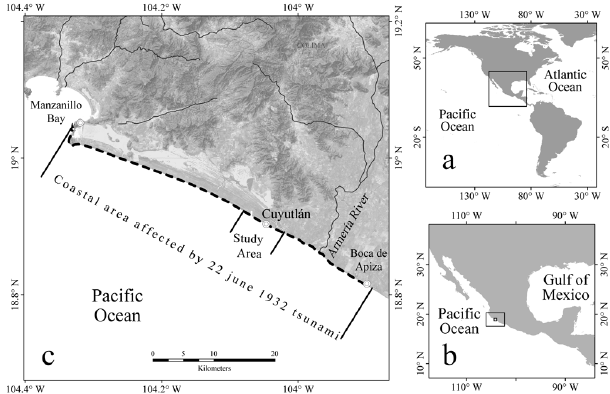
Fig. 2. Study area location. (a) Regional setting, (b) Mexico, and (c) study area. Dash line shows the tsunami area affected by the June 22, 1932 tsunami (NGDC,